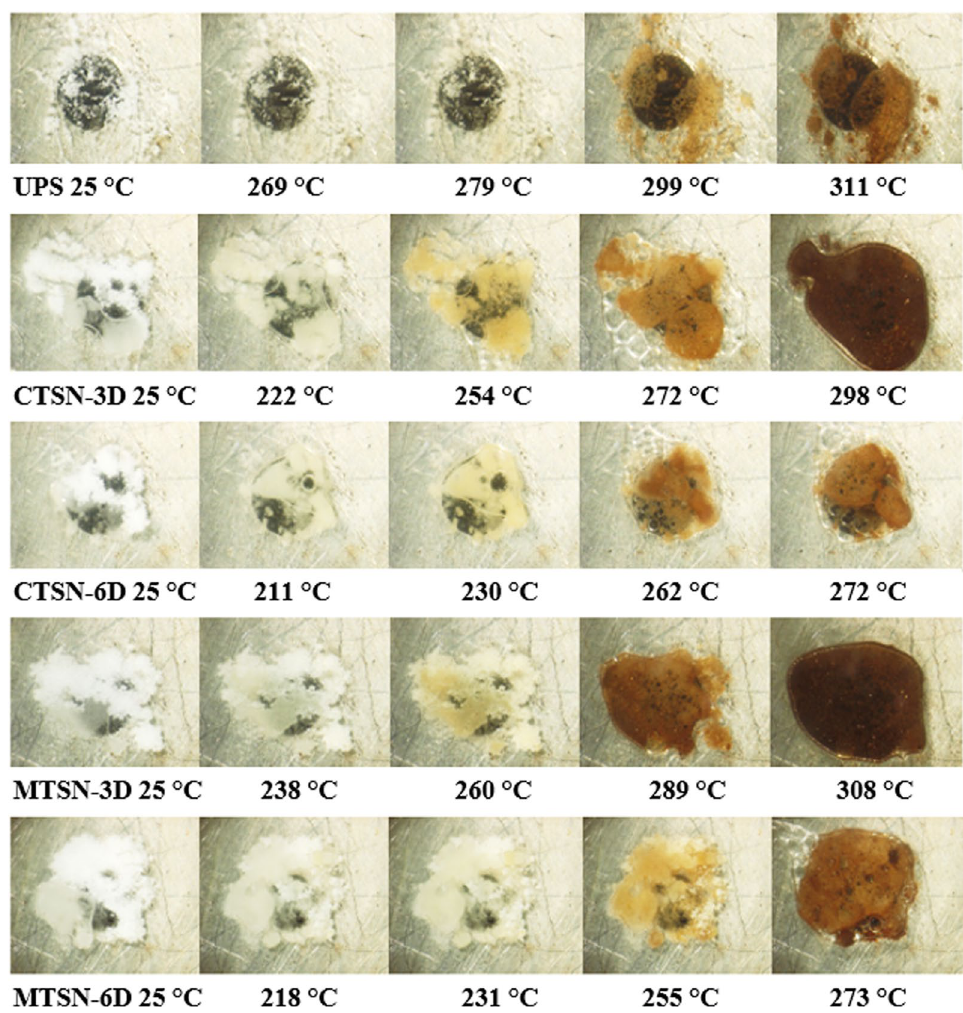
Fig. 4 Photomicrographs illustrating the thermal behavior of UPS, CTSN-3 days, CTSN-6 days, MTSN-3 days, and MTSN-6 days during heating at a rate of 10 °C/min. The overlay and comparison of hot-stage microscopy pictograms of untreated potato starch (UPS) versus chemically treated starch nanoparticles (CTSN) and mechanically treated starch nanoparticles